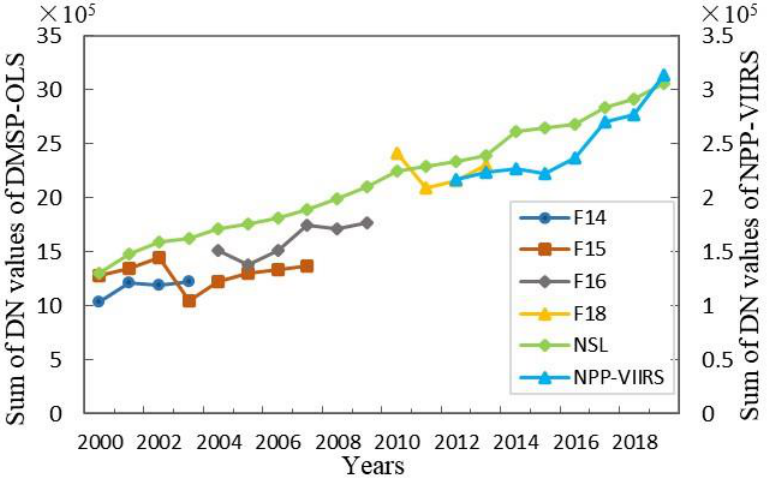
Figure 6. Night light values before and after correction.